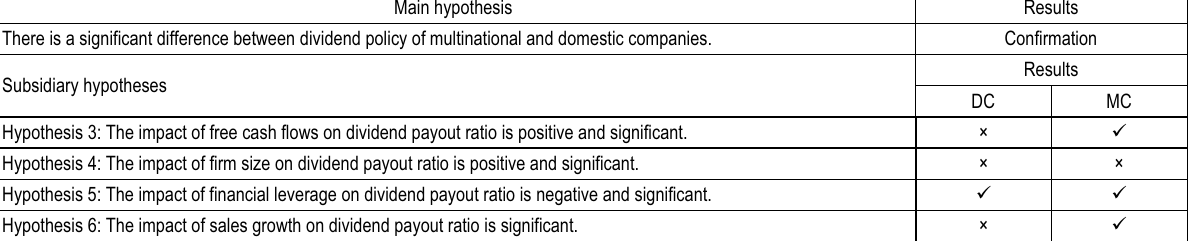
Table 8 (cont.). Summary of results Main